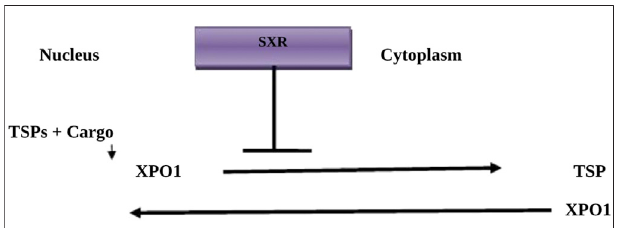
FIGURE 2 | Mechanism of Selinexor action: Tumor suppressor proteins (TSPs) and cargo proteins bind to exportin-1 (XPO1), which transports